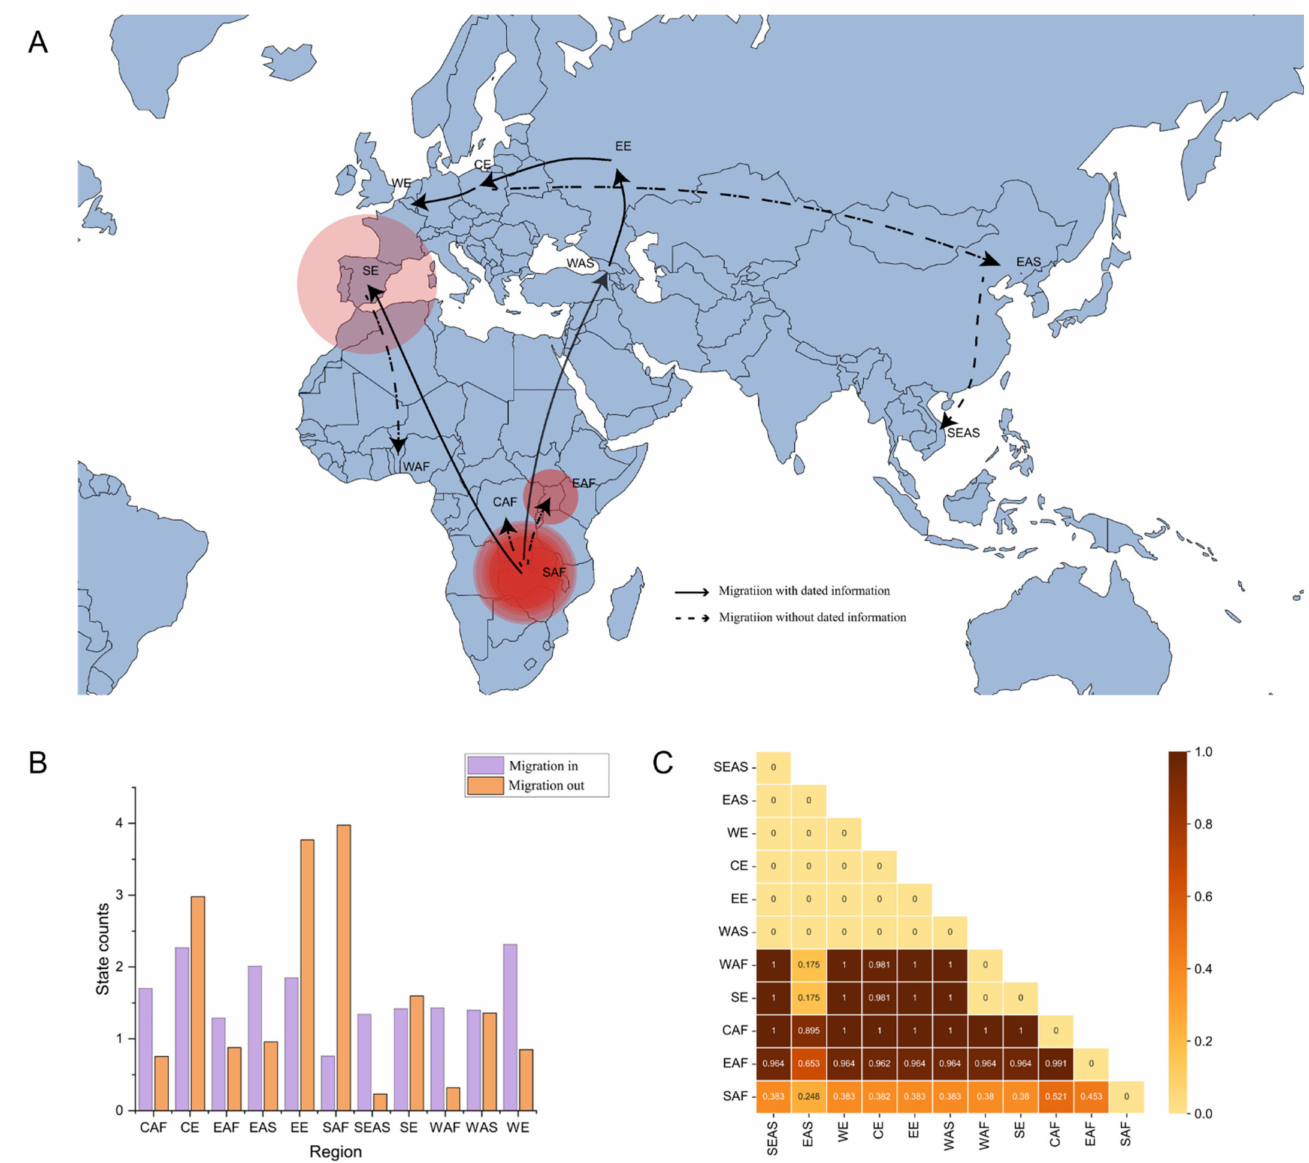
Figure 3. Spatial diffusion of ASFV: ( A ) spatial diffusion pathway of ASFV. The dark lines with arrows represent the transmission pathway of ASFV. The solid line indicates the known ASFV migration pathway, and the dashed line indicates the unproven ASFV migration pathway. ( B ) The purple color represents ASFV migration into the region, and the orange color represents ASFV migration out of the region. ( C ) Pairwise F ST of ASFV